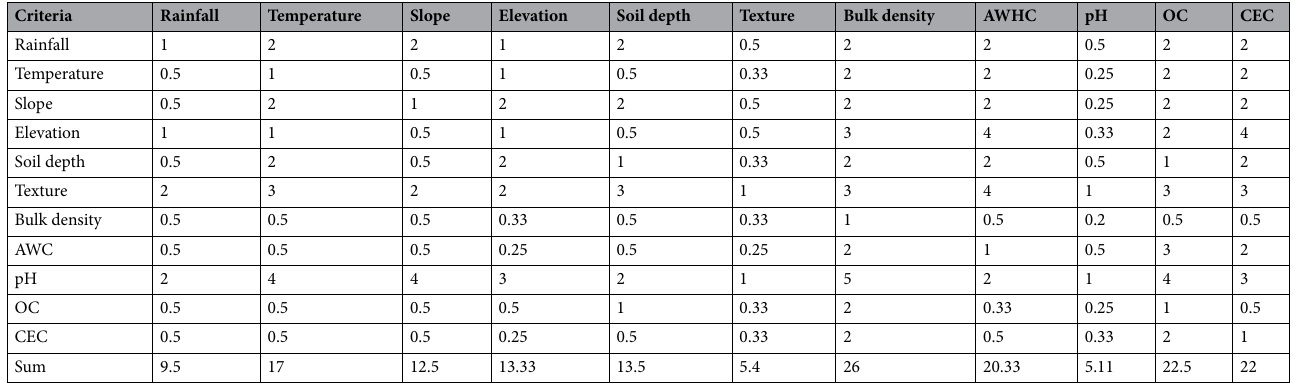
Table 6. Pair-wise comparison